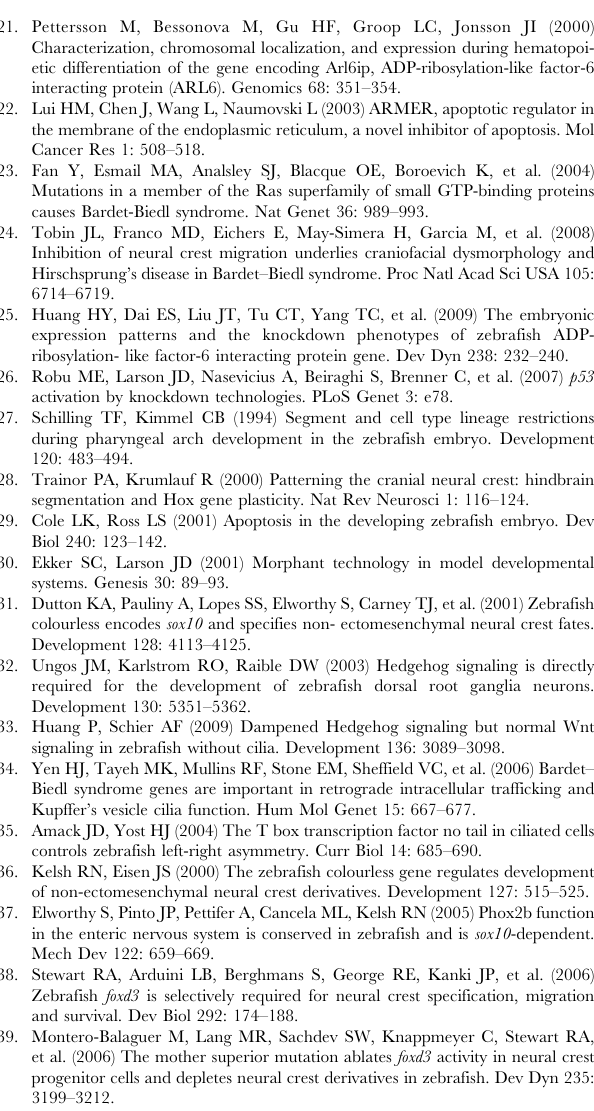
Figure S7 Specific knockdown of Arl6ip1 in DFCs alters LR development without other effects on embryogenesis. (A) As observed under fluorescent microscopy, injection of fluorescein- tagged arl6ip1 -MO1 into mid-blastula stage embryos was observed in dorsal forerunner cells (DFCs) 3–4 hr post-injection at 70% epiboly stage. The dorsal margin was indicated by dashed line. (B– E) Lateral views of 24hpf embryos. Embryos were observed under transmitted light microscopy (B, C) or fluorescent microscopy (D, E). MOs were present in all cells of embryos injected at the one- cell stage (D), and severe defects induced by fluorescein-tagged arl6ip1 -MO1 embryos were shown (B). Fluorescein-tagged arl6ip 1- MO1 injected into embryos at mid-blastula stage was primarily found in the yolk cell and yolk tube (E), indicating that cells, other than DFC and yolk, did not incorporate MO. These DFC of arl6ip1 -MO1-injected embryos (DFC arl6ip1 -MO1 ) developed a nor- mal morphology (C) similar to WT embryos. (F, G) Tail views of 6- somite stage embryos. KV was indicated by arrows. Compared